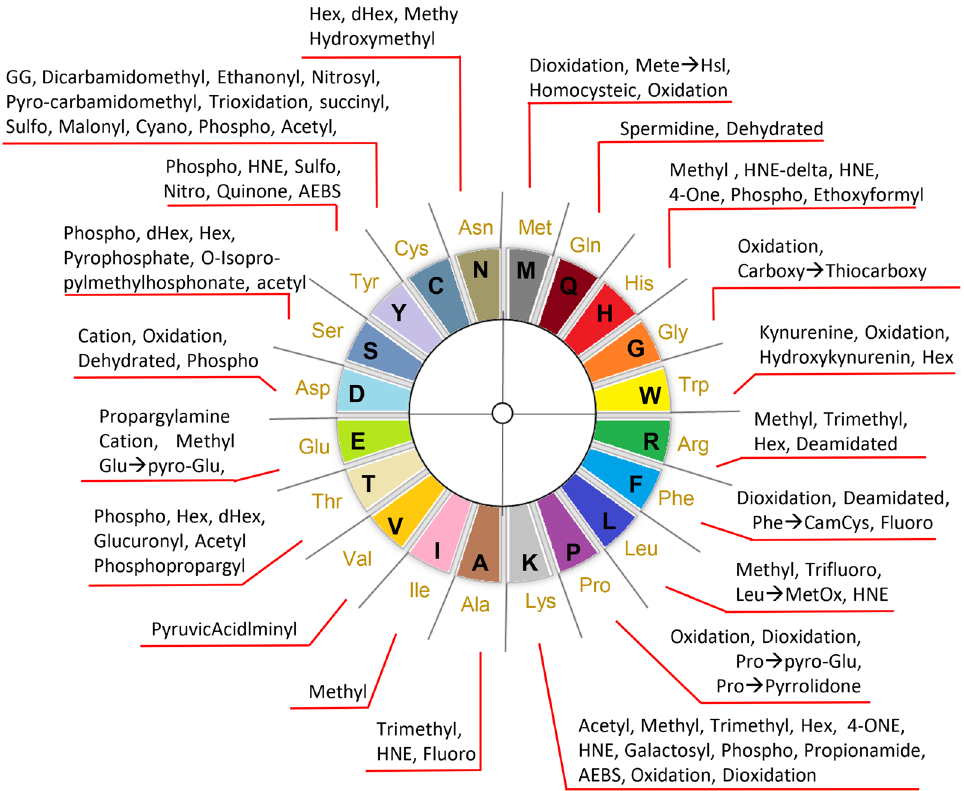
Figure 2. Representation of the post translational modifications identified in our study and their distribution across amino acids. Circular representation of the twenty amino acids and information on the post translational modifications identified on each amino acid. The PTMs were identified in human heart tissues from three chambers (RA, LA, LV) and are represented post processing and FDR control at 0.05. For abbreviations of PTMs see Supplementary Table